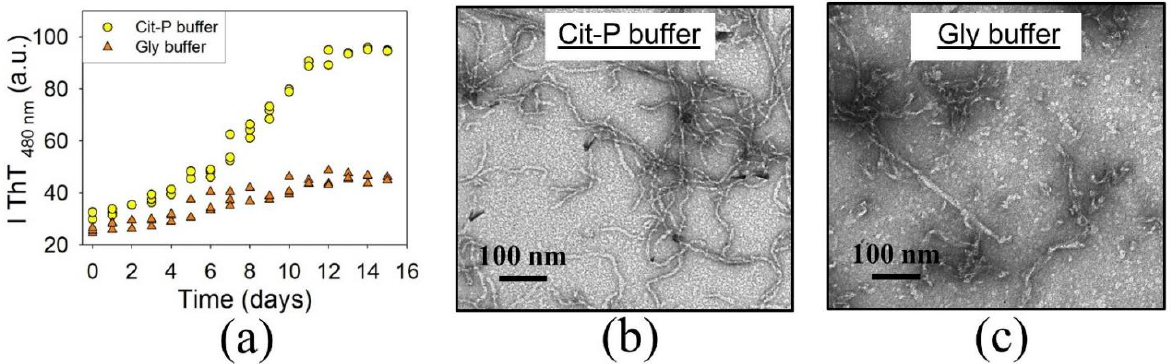
Figure 1. Kinetics of BCAB amyloid formation at рН = 2.7 and 57 °C recorded by thioflavin T fluorescence assay (for each condition three repeated experiments have been carried out) ( a ). Electron micrographs of aggregates formed after 15 days of incubation in citrate-phosphate (Cit-P) ( b ) and glycine (Gly) ( c ) buffer solutions.